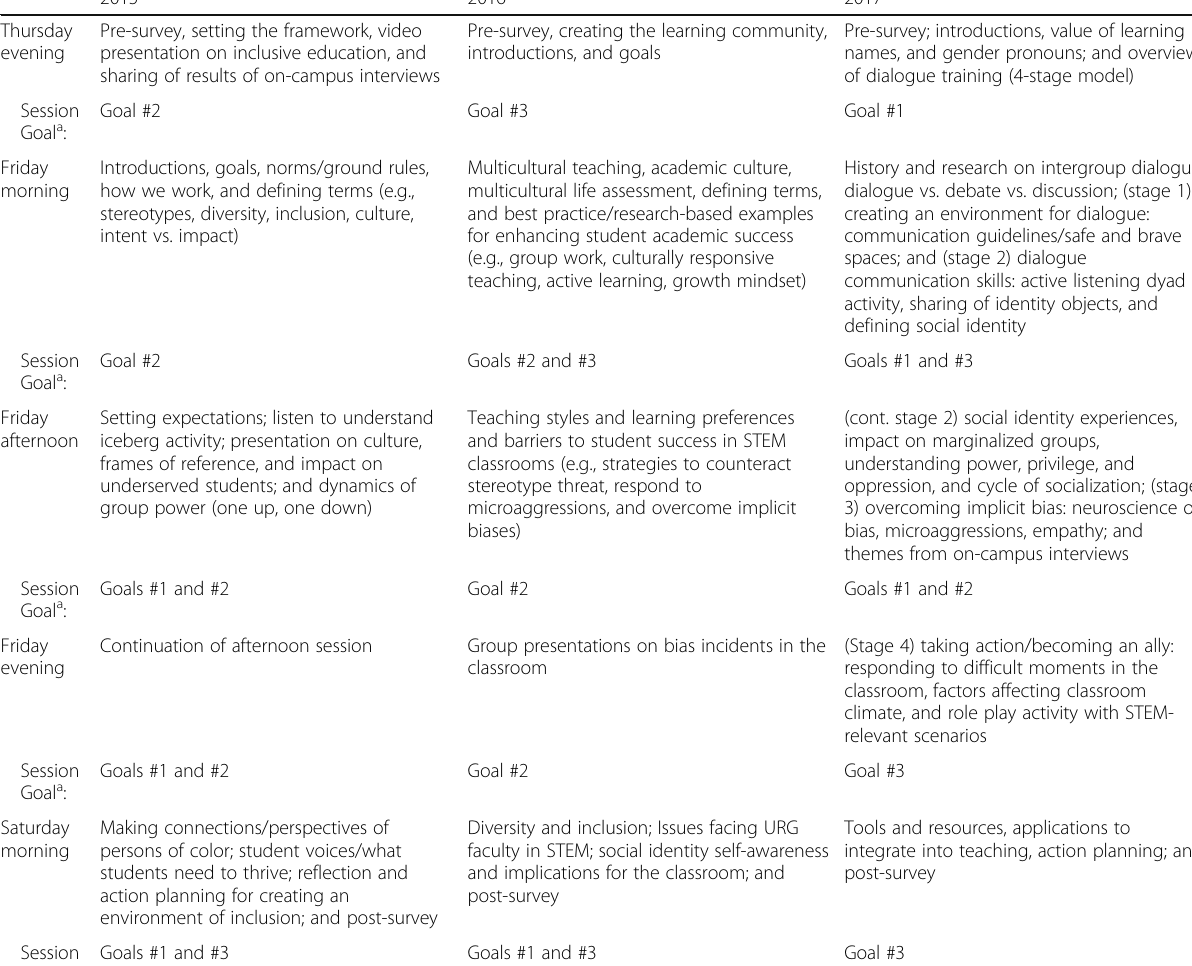
Table 2 Agenda for Inclusive Excellence Workshops by year with goals highlighted for each